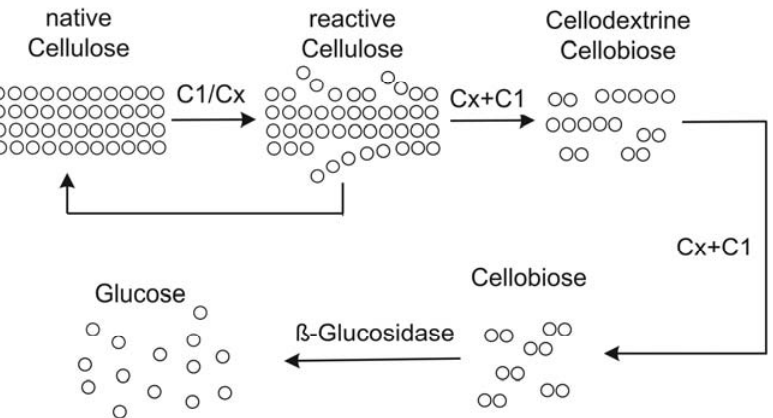
Figure 2. Suggested reaction mechanism of cellulose hydrolysis with a cellulase